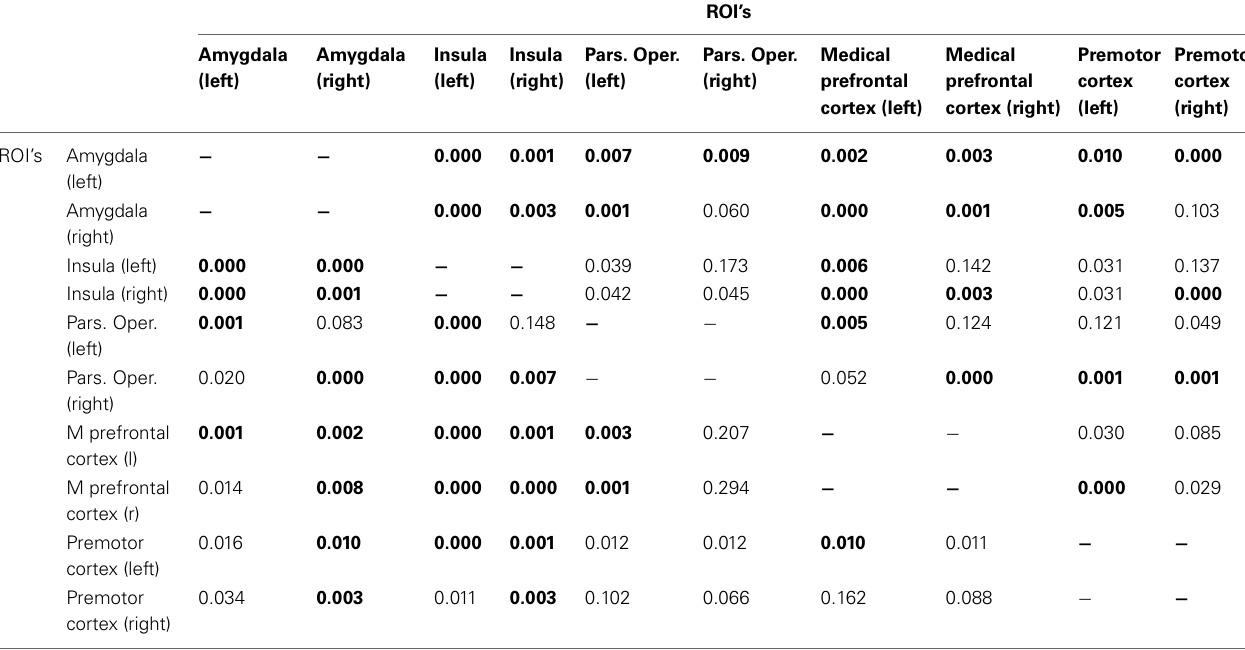
Table 2 | G/G group: Bivariate cross − ROI analysis: p − values for the Haugh test for testing whether ROI i ( i th row) Granger − causes activity in ROI j ( j th